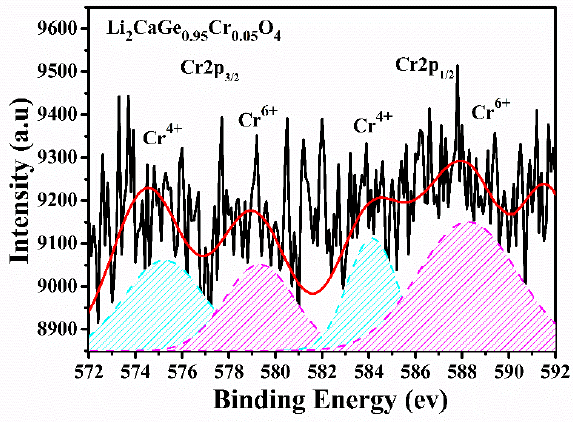
Figure 13. Narrow scanning spectra of XPS for Cr2p.